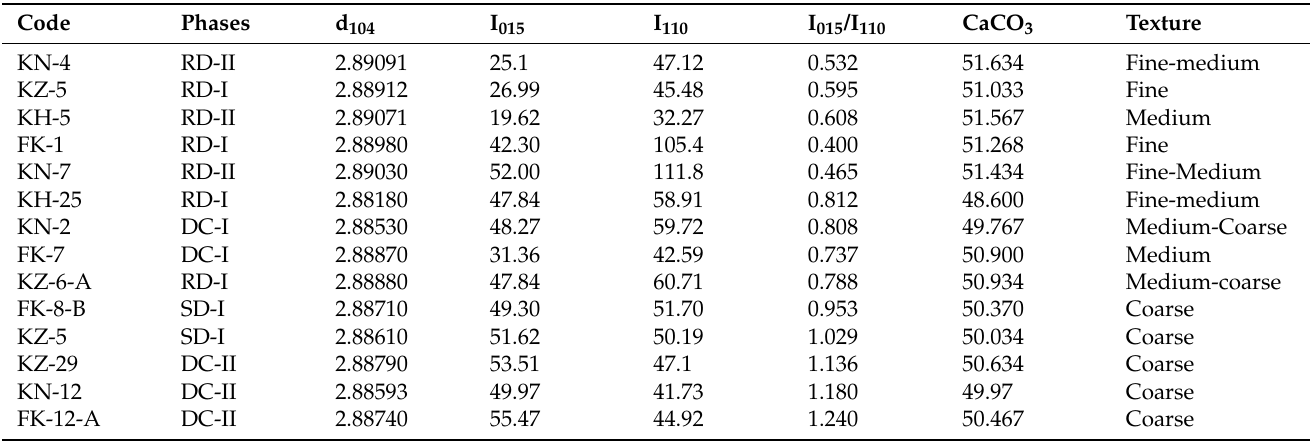
Table 1. Molar % of CaCO 3 and ratios of peak intensities by simple arithmetic calculation and Lumsden’s